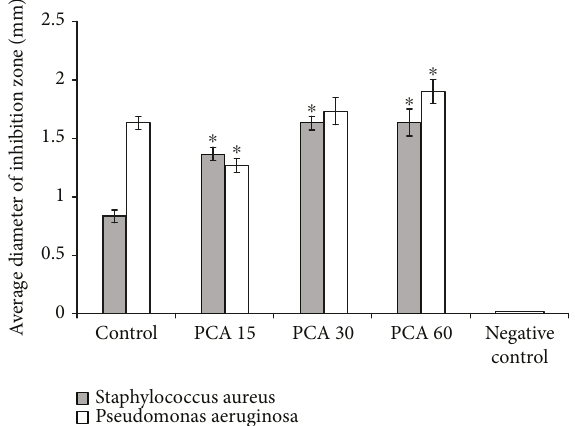
Figure 4: The average diameter of the inhibition zone (mm) of 5 samples against bacterial strains ( S. aureus and P. aeruginosa ) in agar media. The error bars presented as mean ± SD. Asterisks on the bar graph indicate signi fi cant ( p < 0 05 ) di ff erence with respect to the control